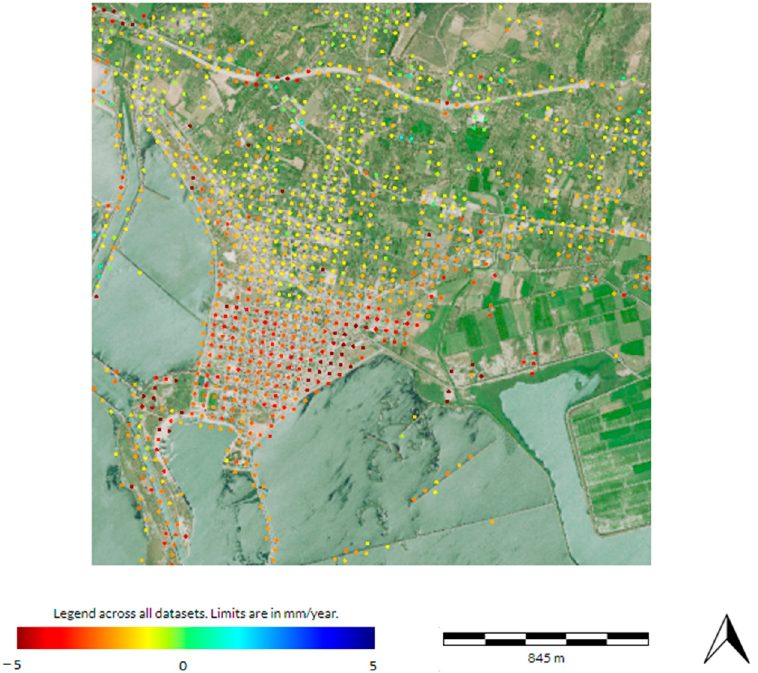
Figure 11. Vertical displacements from the European Ground Motion Service of Copernicus in Messolonghi.